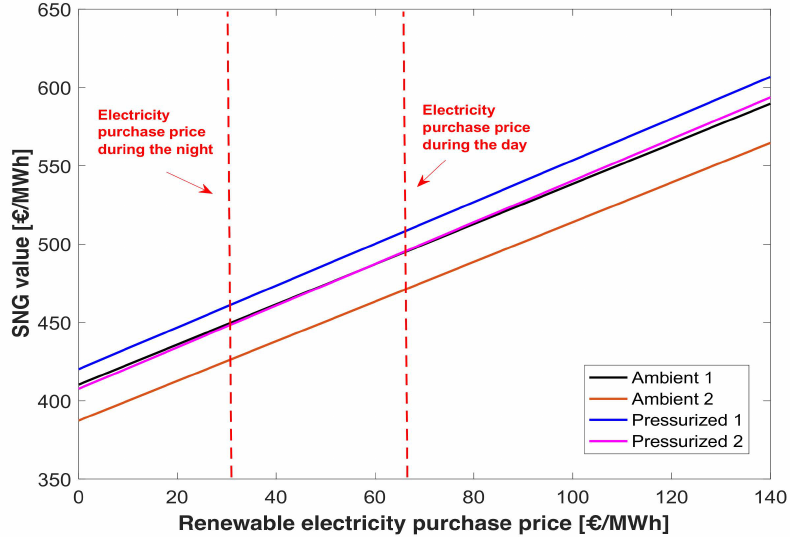
Figure 9. SNG value as a function of the renewable electricity purchase price for the P2G configu- rations, with ratio between the P2G power size and the renewable generation peak power equal to 1/1.7 and without carbon tax